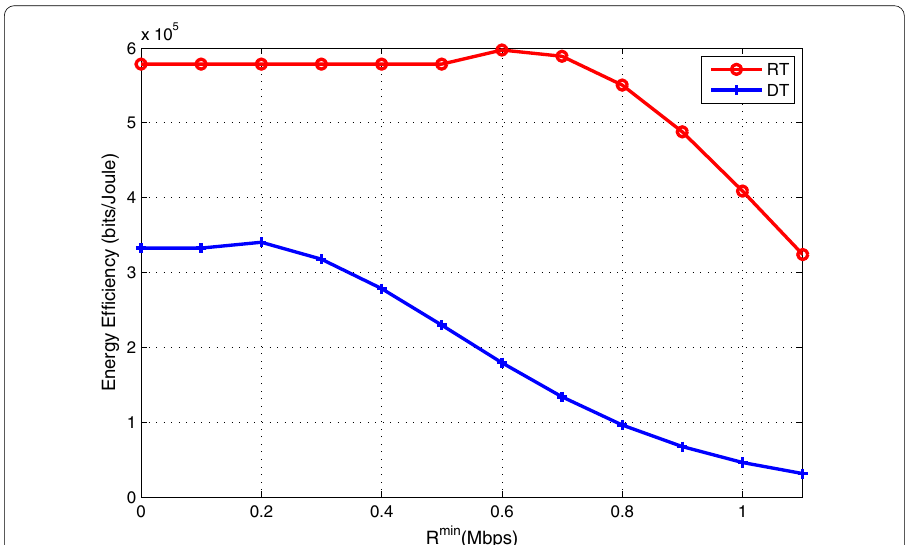
Fig. 7 Path energy efficiency versus minimum data rate requirement R